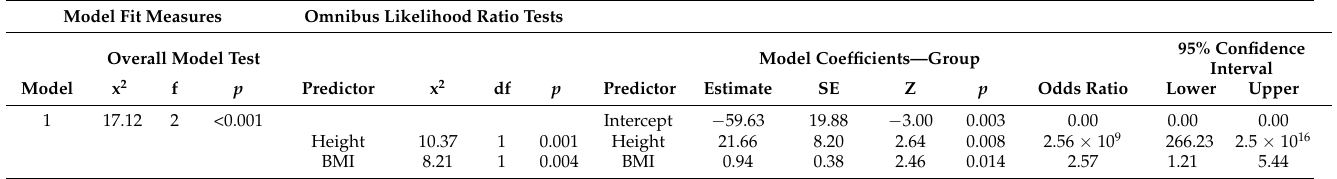
Table 3. Model fit Measures, Omnibus Likelihood Ration Tests, and Model Coefficient.